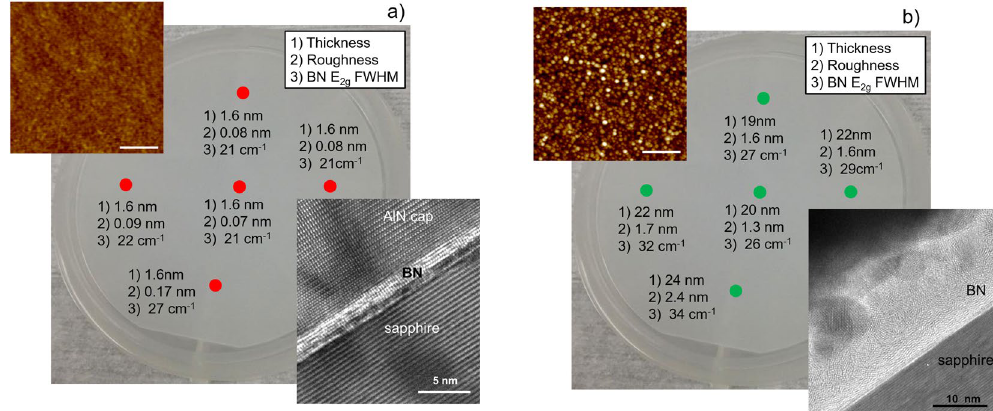
Figure 1. Boron Nitride on sapphire as a substrate for graphene. Optical image with BN thickness, roughness, and full width at half maximum of sp 2 BN E 2g Raman mode at five points for ( a ) smooth and ( b ) rough BN/ sapphire substrates. Top left insets are AFM images for the center of each BN/sapphire substrate (scale bar 250 nm) and bottom right are cross-sectional TEM